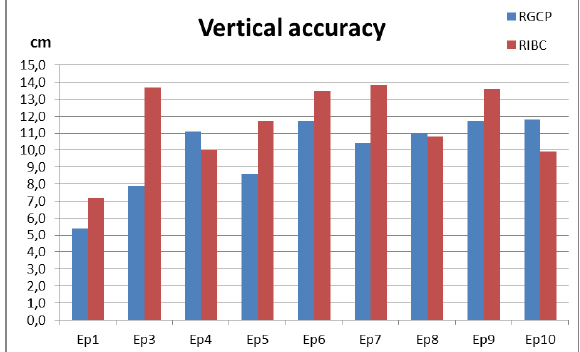
Figure 8. Comparison of vertical RMSE between RIBC and RGCP